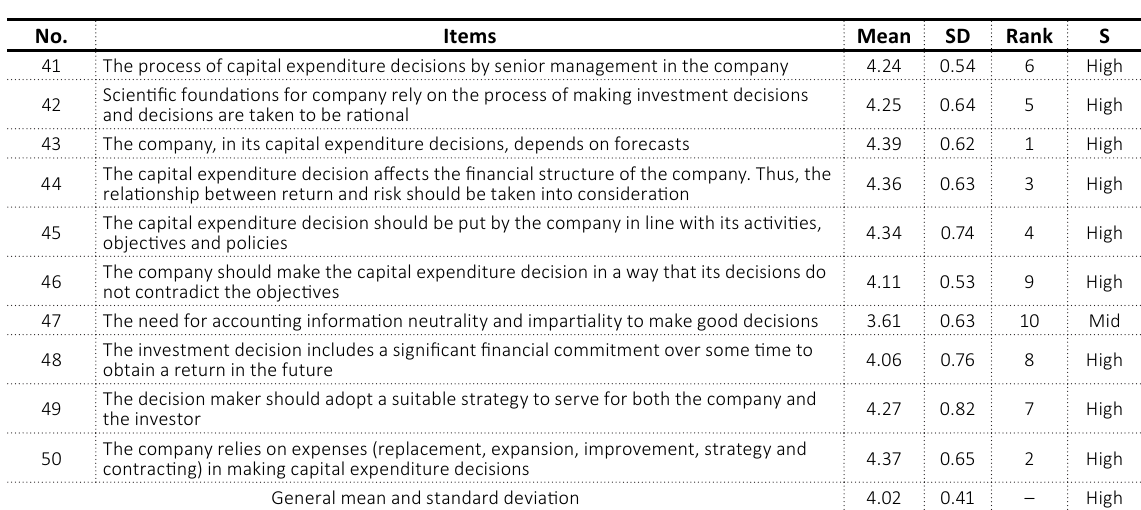
Source: Author’s estimation